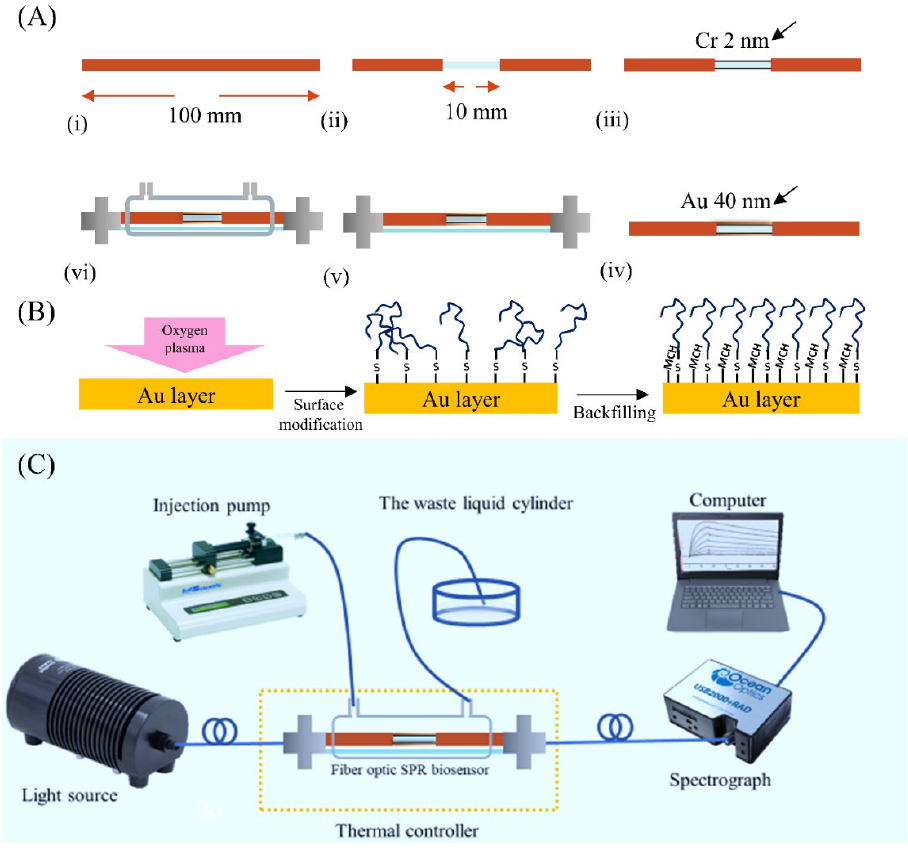
Figure 1. ( A ) The manufactory process of the biosensor: (i) fiber preparation; (ii) cladding layer exfoliation; (iii) chromium deposition; (iv) gold deposition; (v) sensor packaging; (vi) flow chamber packaging ( B ) The surface modification of the biosensor. ( C ) The scheme of the whole detection